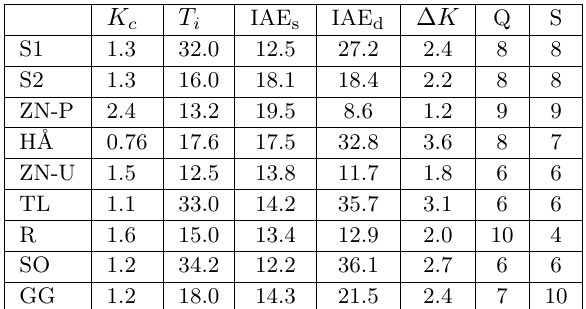
Table 3: Results for different PI controller tunings. (S1 = Skogestad original. S2 = Skoges- tad modified with reduced integral time ( c = 2 ). ZN-P = Ziegler-Nichols’ Process Reac- Figure 19: Good Gain method: Response with P- tion Curve method. H˚A= H¨agglund-˚Astrm’s controller with gain K cGG = 1 . 4 . method. ZN-U = Ziegler-Nichols’